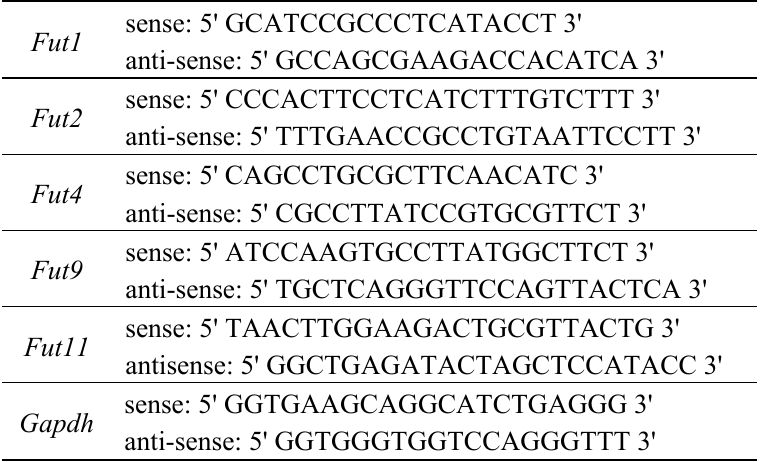
Table 1. Primers for real time PCR of